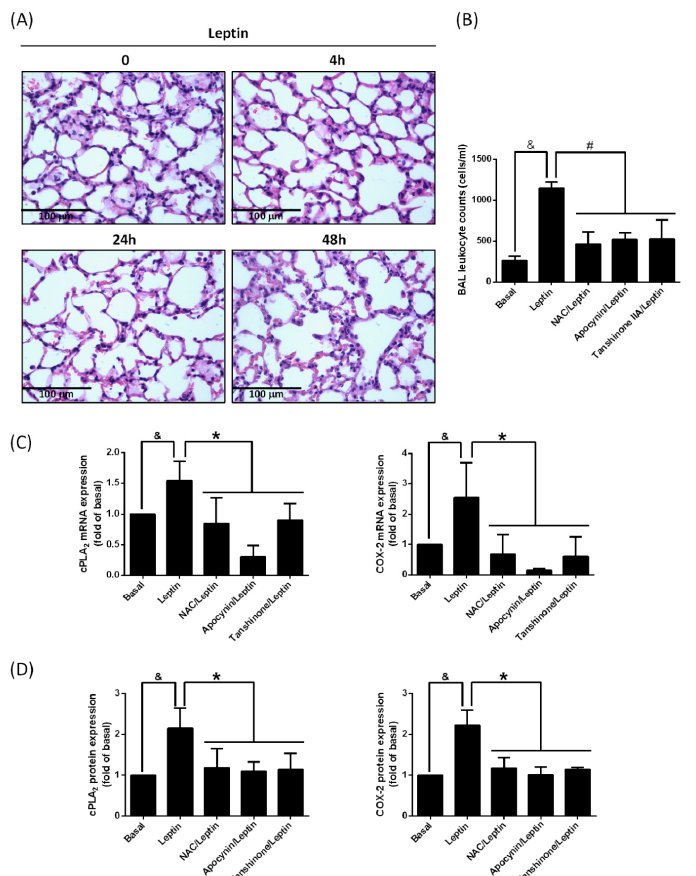
Figure 5. Leptin modulated accumulation of leukocytes and increased expression of cPLA2 and COX-2 genes in lung tissues. ( A ) Mice were i.t. injected with leptin (2 mg/Kg) for the indicated time intervals. Paraffinized lung tissues were sectioned and H&E staining was performed. ( B ) ICR mice were i.p. injected with 2 mg/Kg of NAC, apocynin, or tanshinone IIA for 1 h. Then, mice were i.t. injected with 2 mg/Kg of leptin for 48 h. Bronchoalveolar lavage (BAL) were saved and numbers of leukocytes were calculated using a scil Vet ABC™ Hematology Analyzer. ( C ) mRNA were extracted from lung tissues. RT-PCR was used to detect the mRNA expression of cPLA2 and COX-2. ( D ) Protein were extracted from lung tissues and Western blot was used to detect the expression of cPLA2 and COX-2. Data are expressed as the mean ± SEM of five independent experiments ( n = 5). & p < 0.05 or * p < 0.05 as compared between the two indicated groups.